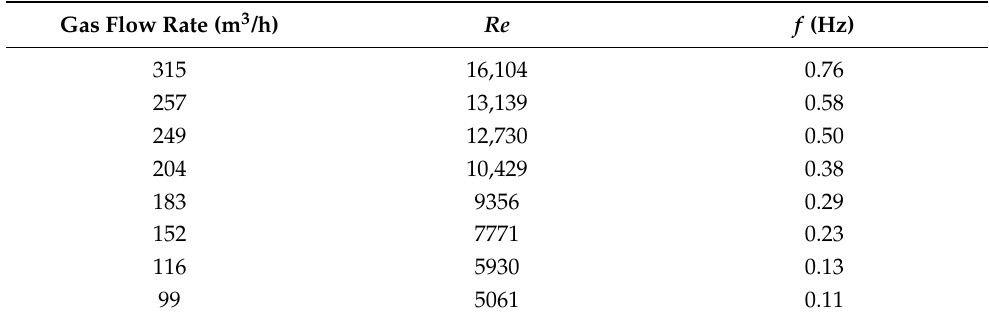
Table 3. Estimated turbulent burst frequency based on inner variables for Designs 1 and 2 (diameter = 0.3